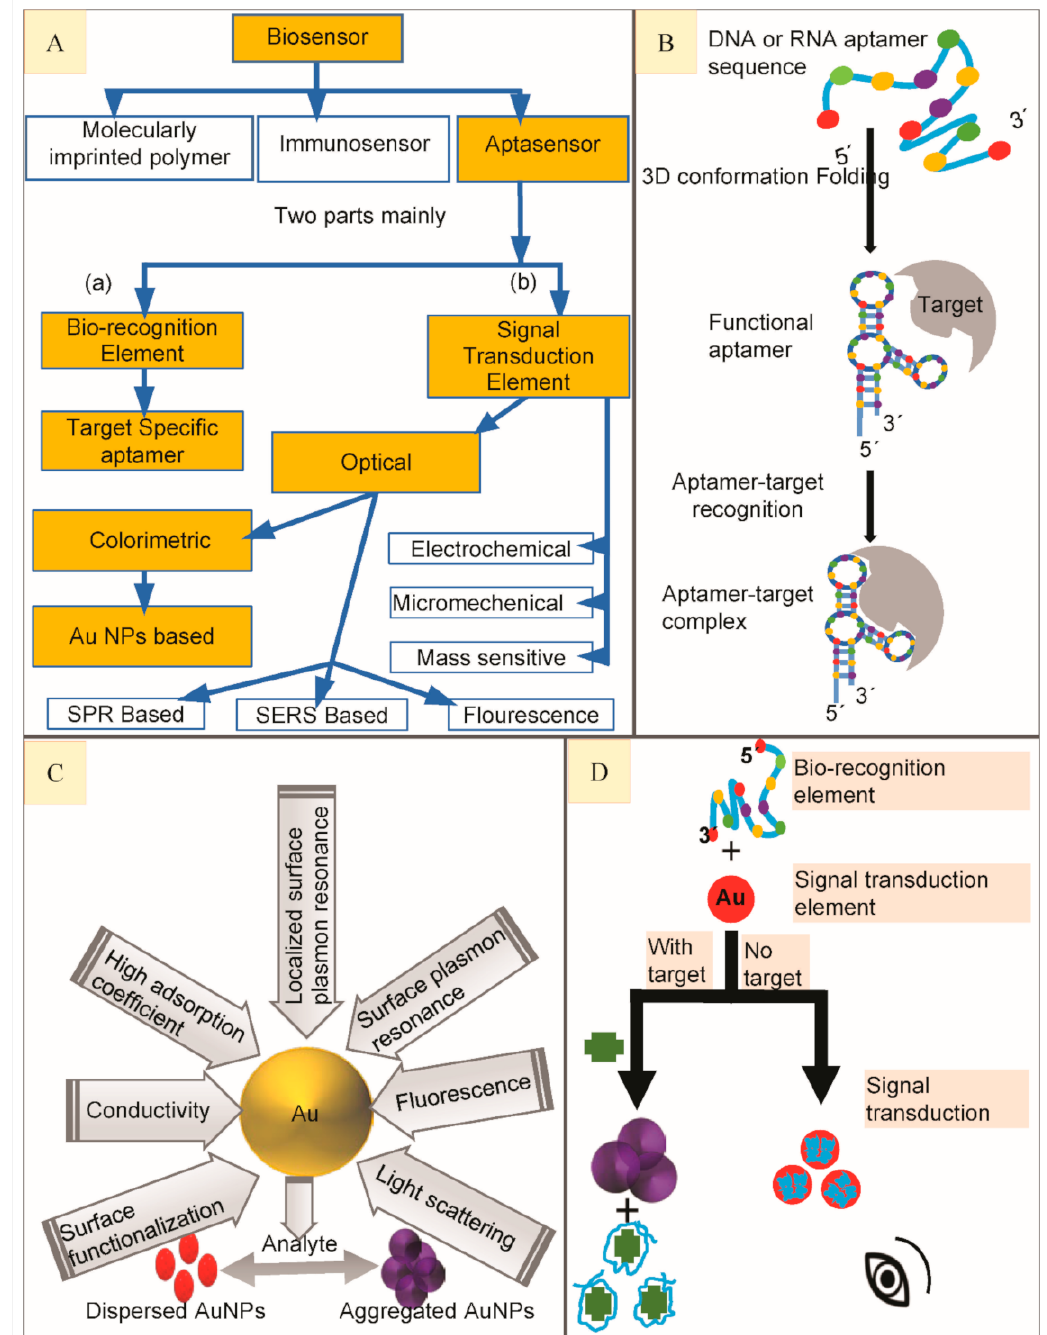
Figure 1. ( A ) Scheme to show main types of biosensors to highlight aptasensor, classification of aptasensors based on its major components to highlight Gold Nanoparticles (AuNPs) based colorimetric aptasensors. ( B ) Generalized depiction of an aptamer library folding to form secondary structure in order to bind with high affinity target molecule to finally make aptamer-target complex. ( C ). Properties of Gold nanoparticles and calorimetry. ( D ) A generalized illustration on working principle of colorimetric aptasensor when bio-recognition element (BRE) combines with signal transduction element (STE) to make a colorimetric aptasensor to detect small molecular